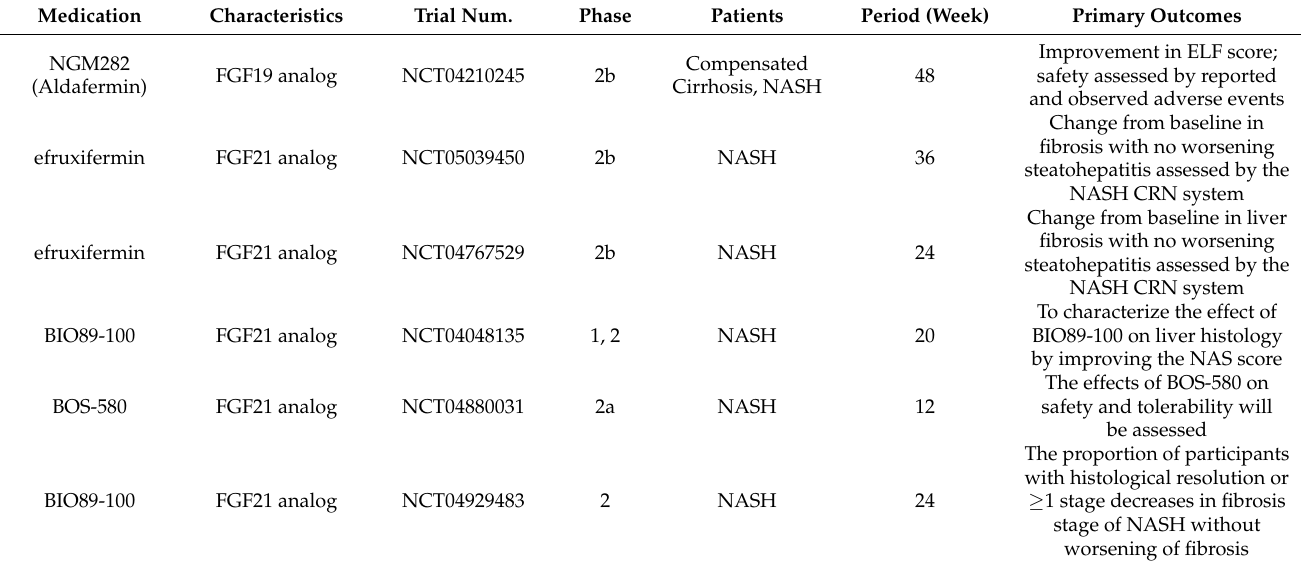
Table 3. Ongoing clinical human studies concerning the potential efficacy of FGF19 and FGF21 on